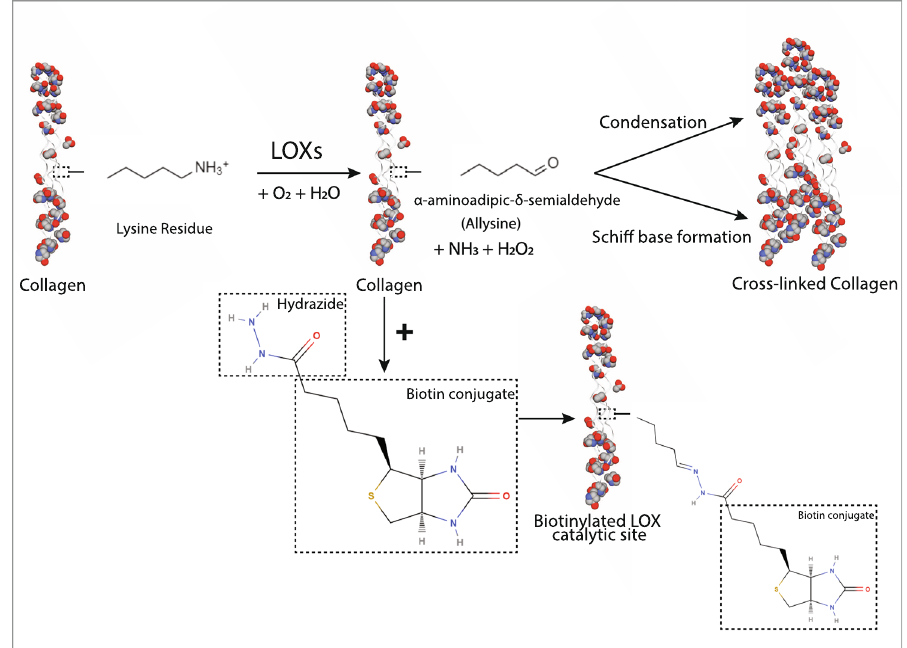
Fig. 1 Reaction of biotin-hydrazide with protein intermediates generated by LOXs-catalysis. Oxidative deamination catalyzed by lysyl oxidases (LOXs) leads to collagen crosslinking by spontaneous condensation. Intermediate semialdehyde and the imine and aldol products of the crosslinking reaction can be labeled by biotinylated hydrazide. LOXs oxidize lysine and hydroxylysine side chains on collagen and elastin to highly reactive semialdehydes called allysines, while producing hydrogen peroxide (H 2 O 2 ) and ammonia (NH 3 ) as byproducts. Allysines then spontaneously condense to form cross-linkages. In our approach to detect LOXL2 activity, adding biotin-hydrazide (BHZ) results in biotinylation of LOXL2-catalyzed peptidyl